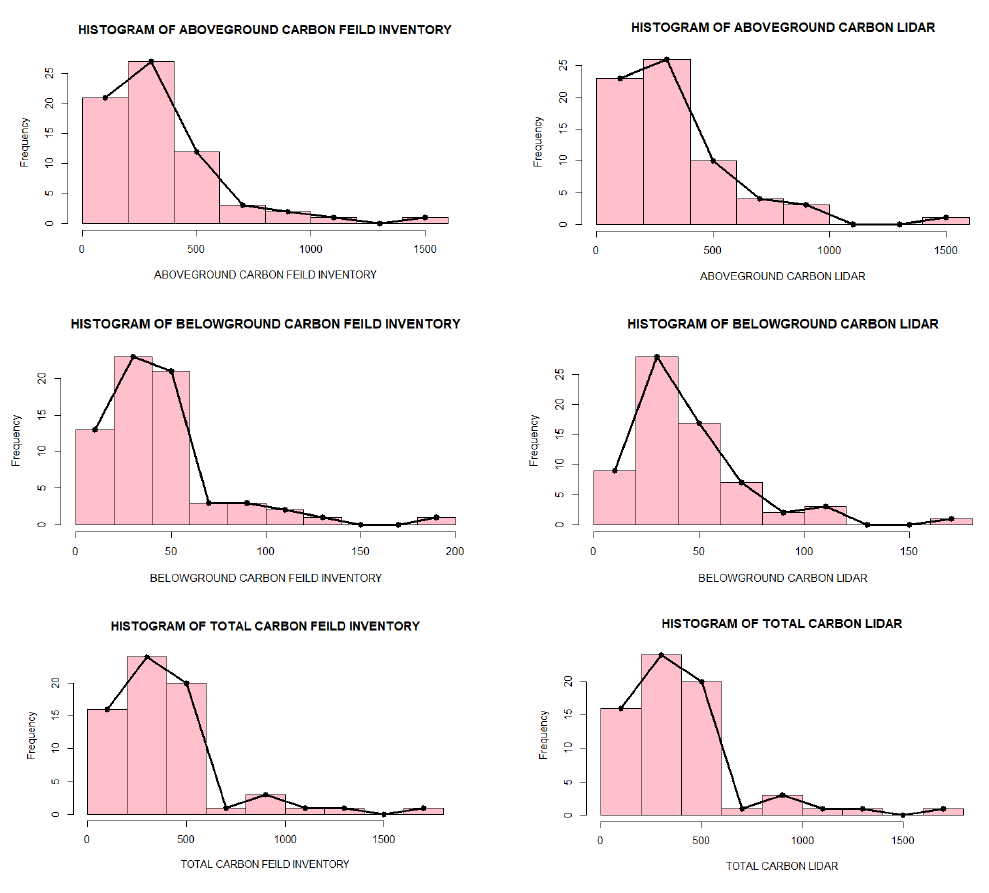
Figure 10. Histogram distributions of aboveground, belowground, and total carbon stock (kg) calculated with two types of inputs (forest parameters from field measurements and those extracted from UAV-ALS and TLS data (Lidar)) .